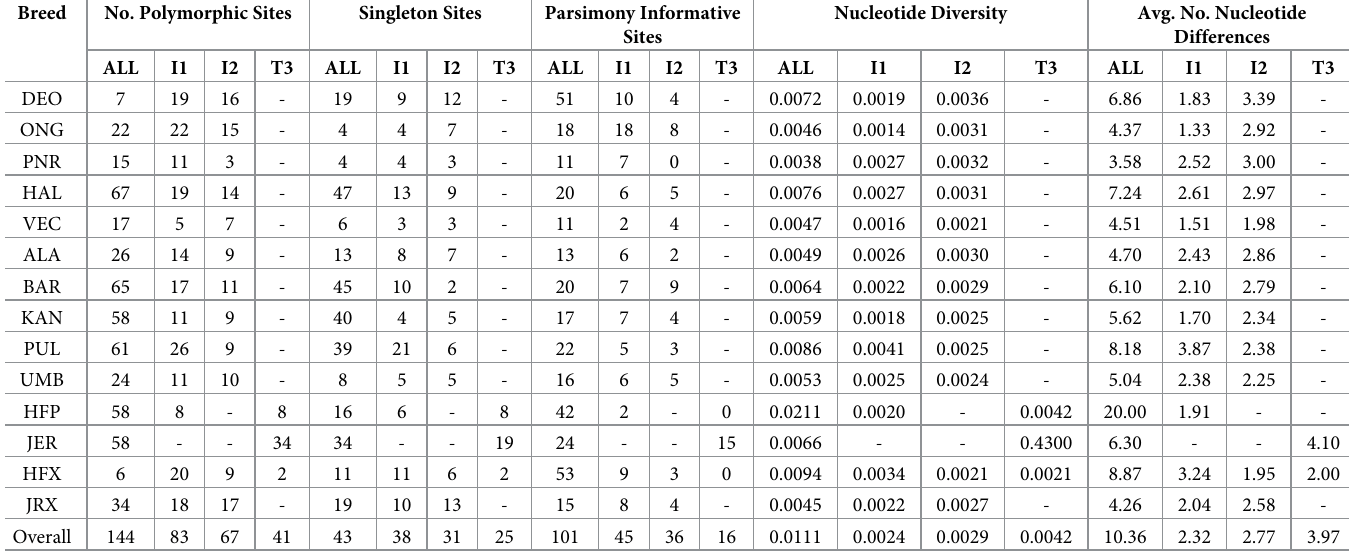
Table 5. Polymorphism and diversity of mtDNA control region haplotypes in zebu, taurine and crossbred cattle of South India. Breed